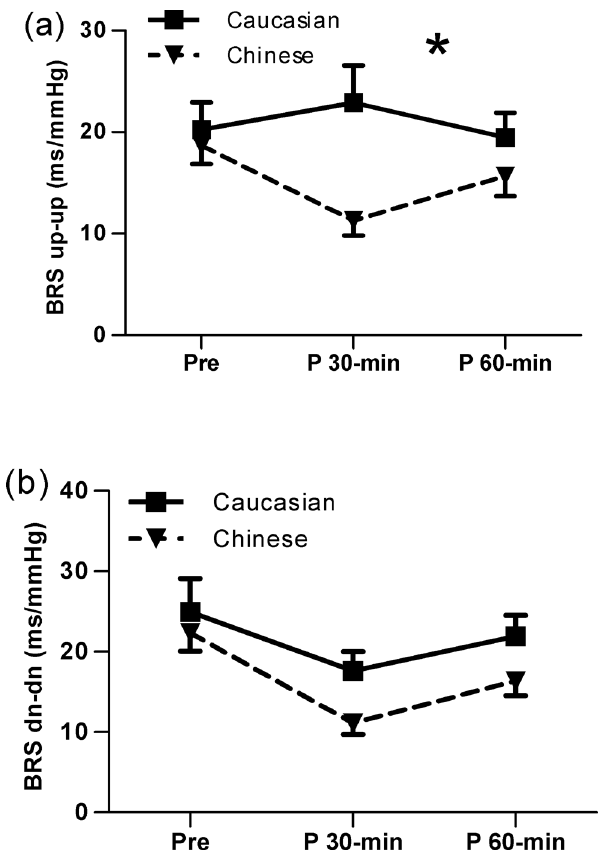
Fig 3. Baroreflex sensitivity (BRS) determined by the sequence method, pre and 30-min and 60-min post exercise in Caucasian and Chinese individuals. (a) BRS(up-up) showed a significant race by time interaction. * P < 0.05 (b) There was no race-by-time interaction for the change in